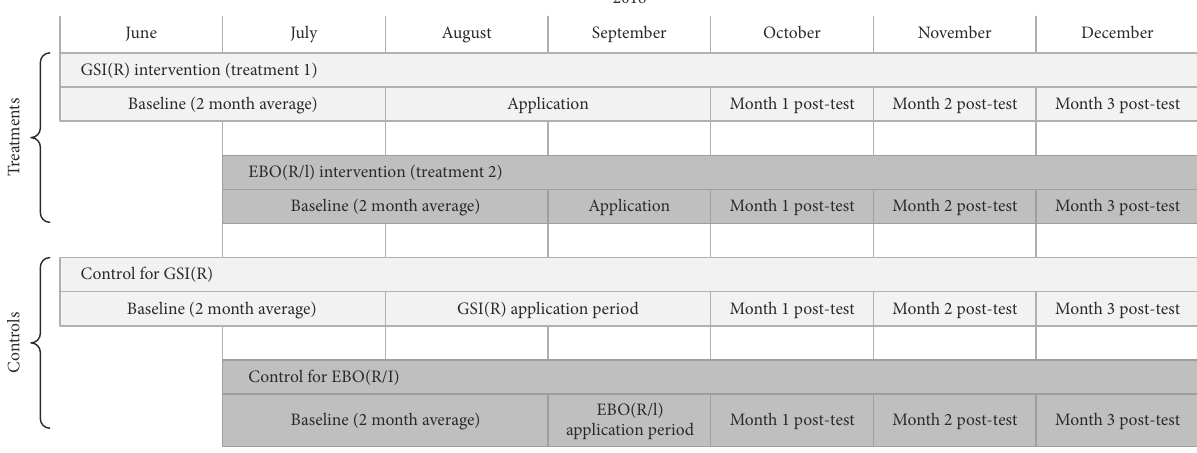
Figure 2. Intervention procedures for Case Study